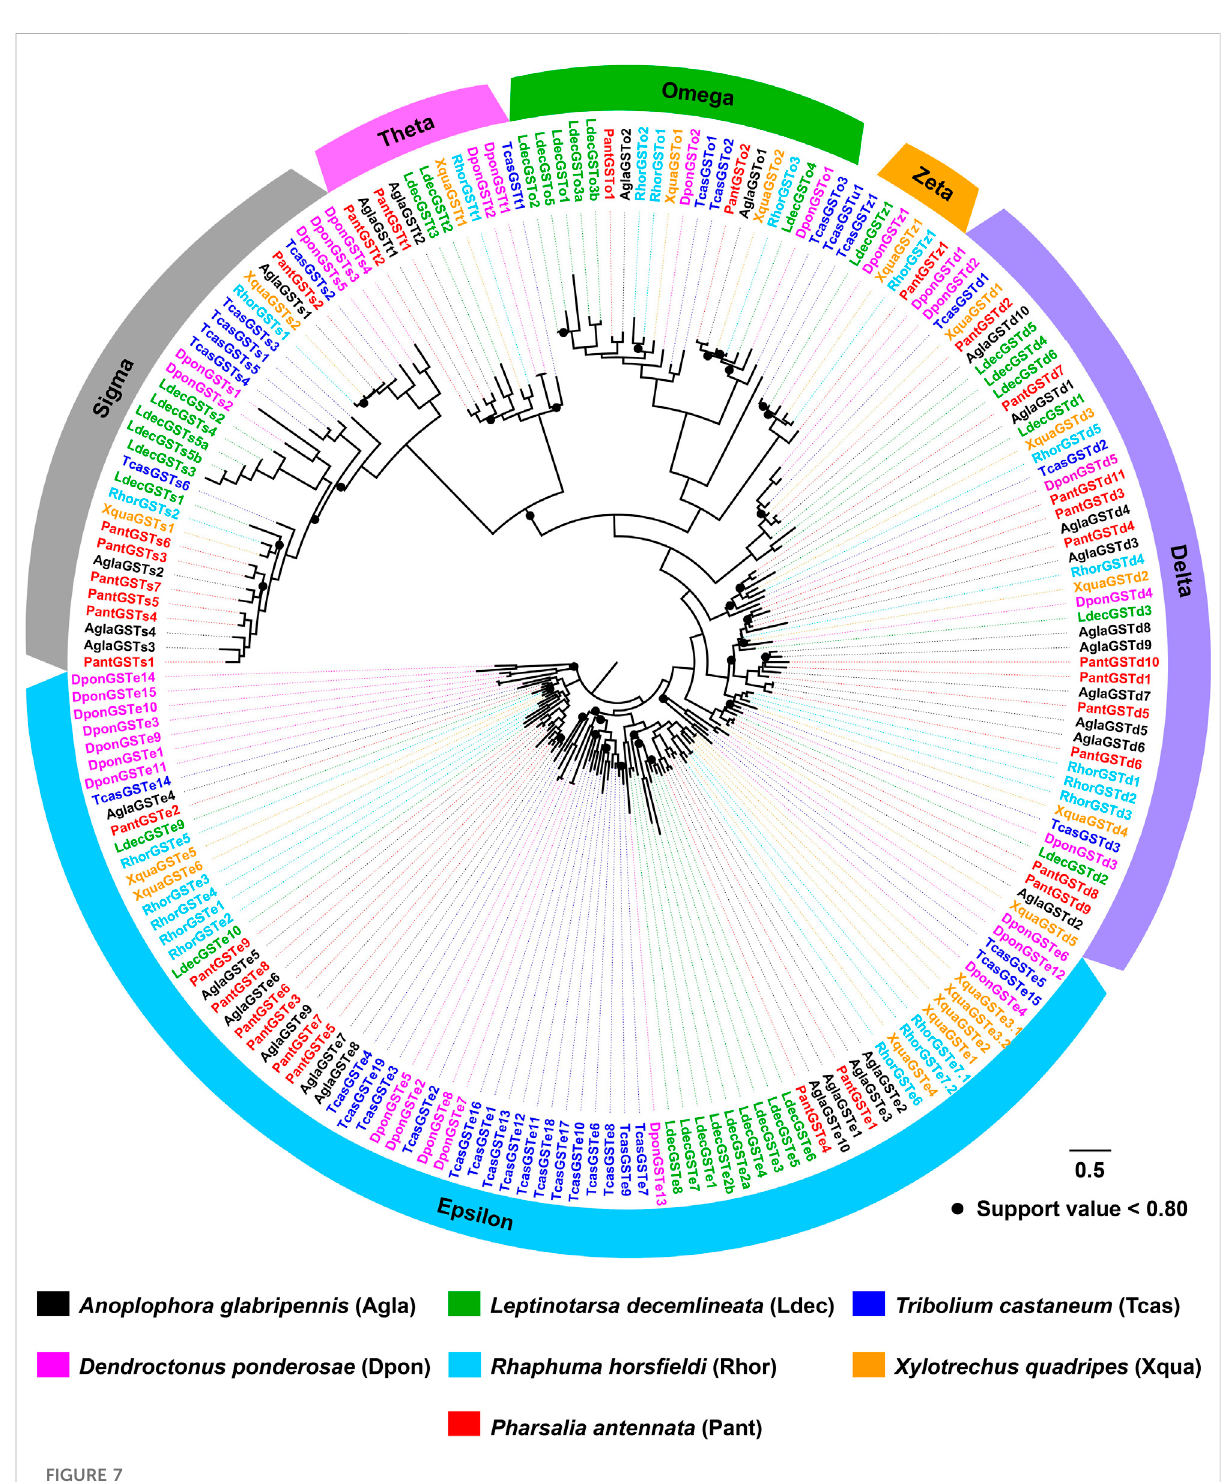
FIGURE 7 Maximum-likelihood tree of GSTs in seven coleopteran species. The GST proteins in P. antennata are highlighted in